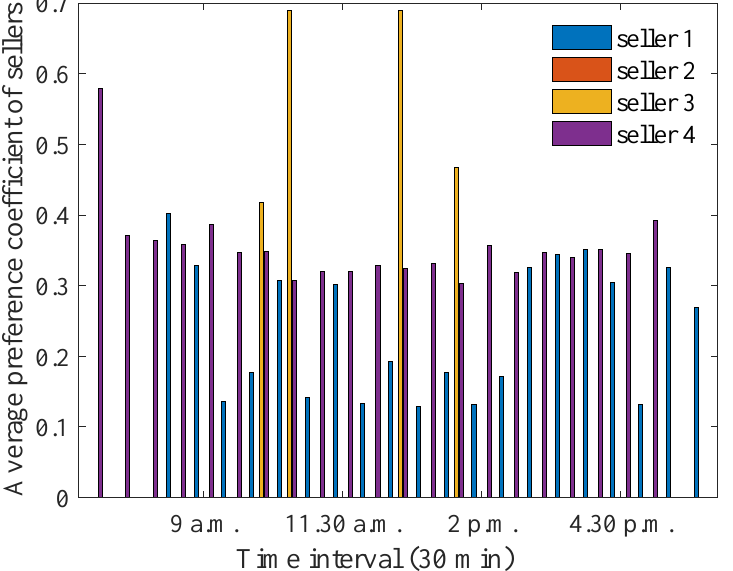
Figure 28. Optimum preference coefficients for sellers when profit threshold is increased to a larger